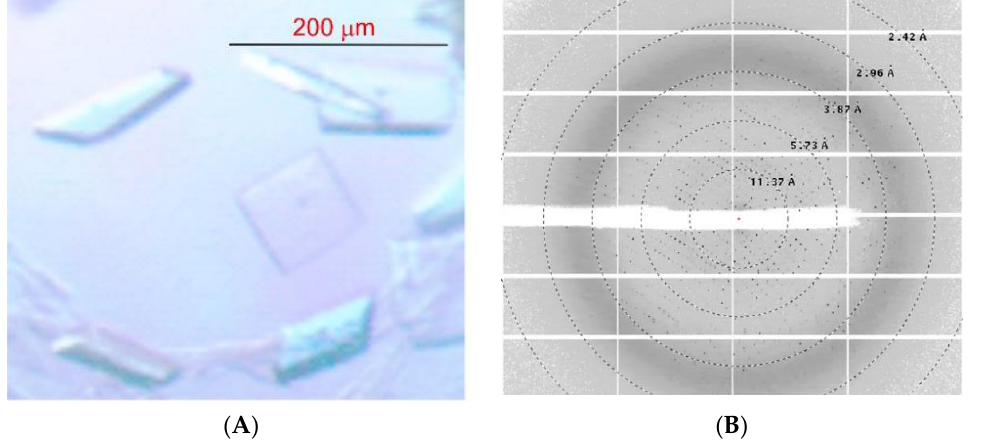
Figure 2. TgGAC full length crystallography. ( A ) Representative native crystals of TgGAC. Scale bar represents 200 μ m. ( B ) Diffraction image from a TgGAC crystal. Resolution rings are annotated.